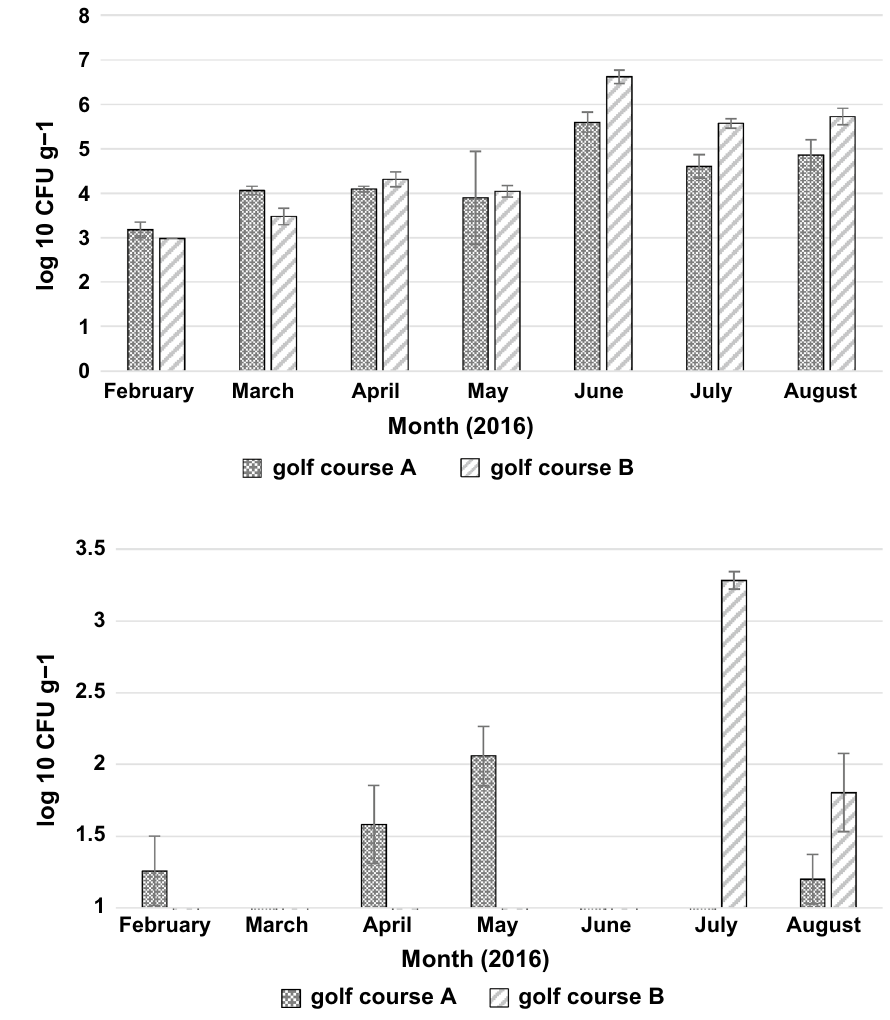
Fig. 8 Monthly variation of